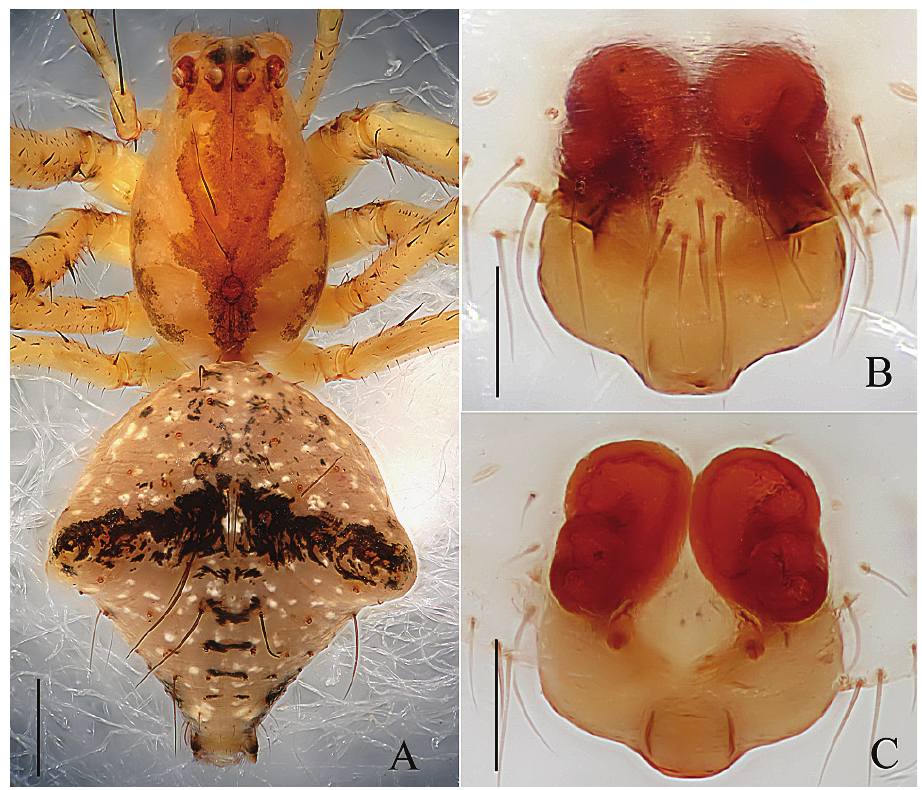
Figure 9. Mimetus wangi sp. n., one of the female paratypes. A habitus, dorsal view B epigyne, ventral view C vulva, dorsal view. Scale bars: A , 0.5; B–C ,